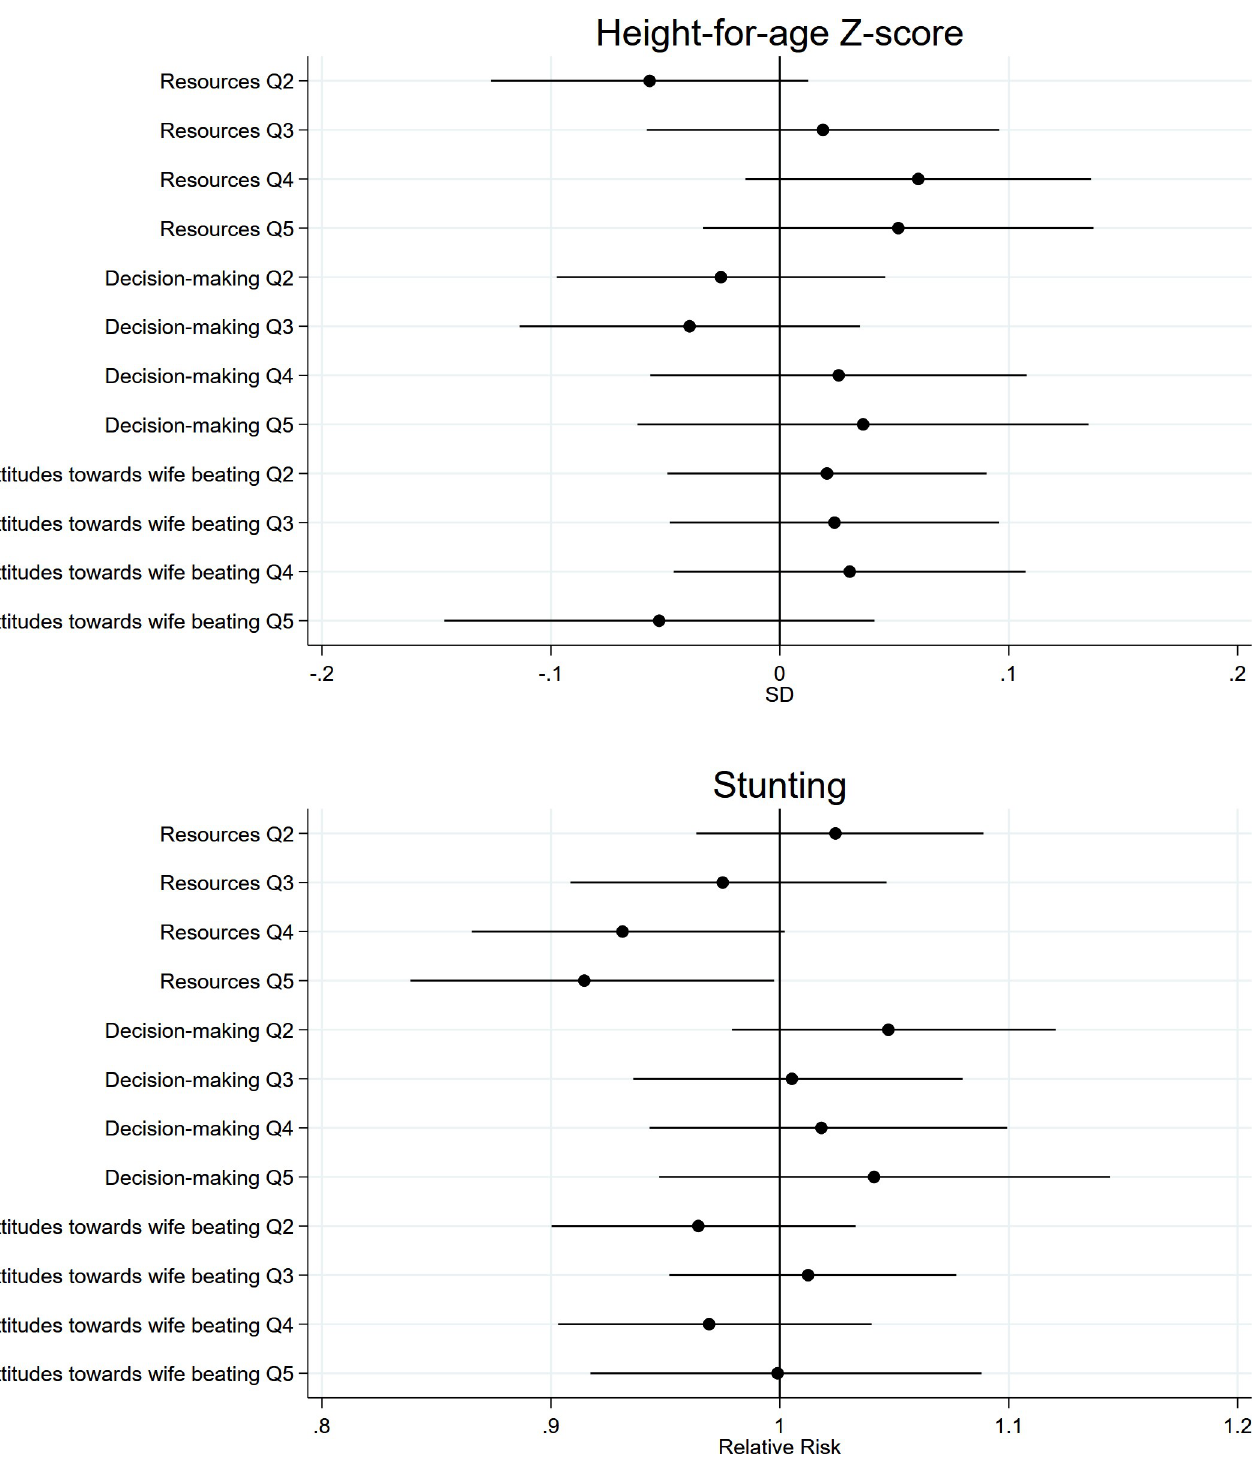
Fig 3. Associations between quintile categories of women’s empowerment dimensions and child growth outcomes. All estimates accounted for clustering and representativeness using country-specific cluster variables and sampling weights and controlled for household wealth, rurality, and size; household head’s age and sex; maternal education, age, and age at first cohabitation; child age and sex; and country and survey year. Reference quintile category is Q1, lowest. Q, quintile category.